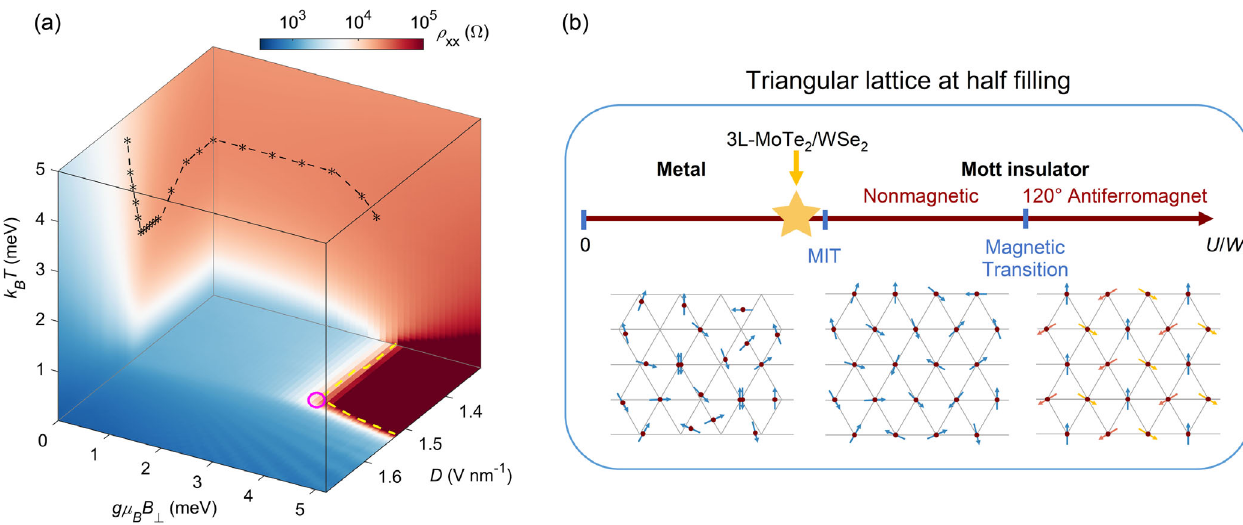
B ⊥ , D , and FIG. 4. Phase diagram of 3 L-MoTe 2 = WSe 2 at half filling. (a) Longitudinal resistivity ρ (in log scale) as a function of g μ xx B k T . The diagram shows three slices of the function. Different states can be identified by the color contrast. The low-field light blue area B denotes the Fermi liquid phase; the dark red area denotes the magnetic-field-induced insulating phase. Lifshitz transition occurs near 1 . 5 V nm − 1 and generates a dark blue area at large D . In the dark blue area at the base temperature, Landau fan can be observed. The B ⊥ − D plane, the coherent- pink circle, the asterisk symbols, and the dashed yellow curves highlight the tricritical point in the g μ B incoherent transport crossover temperature T (cid:2) , and critical field B , respectively. (b) The expected phase diagram of the triangular lattice c Hubbard model. Our 3 L-MoTe 2 = WSe 2 lies on the left boundary of the MIT (denoted by the yellow arrow and star). Lower-panel schematics show the real-space charge distributions and spin orientations (denoted by the arrows) for corresponding phases. The metal and nonmagnetic insulator phases have random spin orientations, while the system favors 120° N´eel order in the large U=W